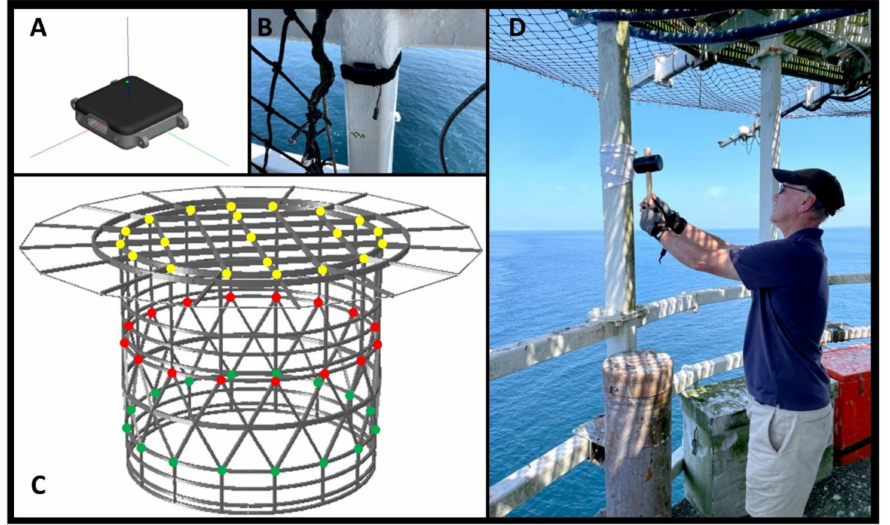
√ Hz noise floor. ( B ): An